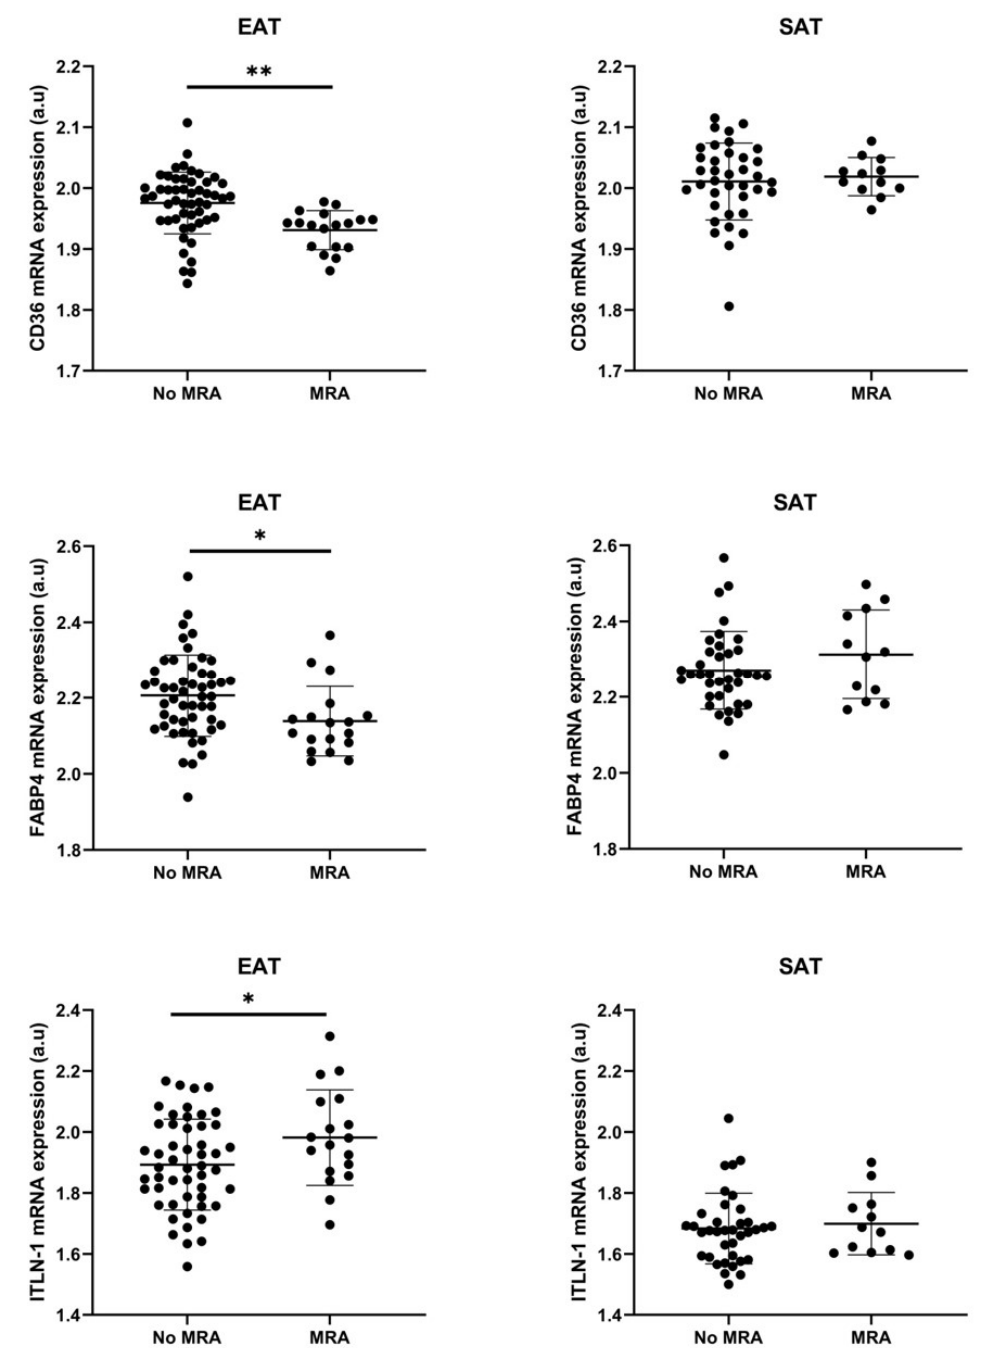
Figure 3. MRA on FABP4, CD36 and ITLN-1 Dot plots and mean ± SD represent the mRNA expression levels of FABP4, CD36 or INTL-1 in epicardial and subcutaneous fat in a.u. from patients with or without mineralocorticoid receptor antagonist (MRA). Unpaired t test showed statistical differences between groups ** p < 0.01, * p < 0.01.